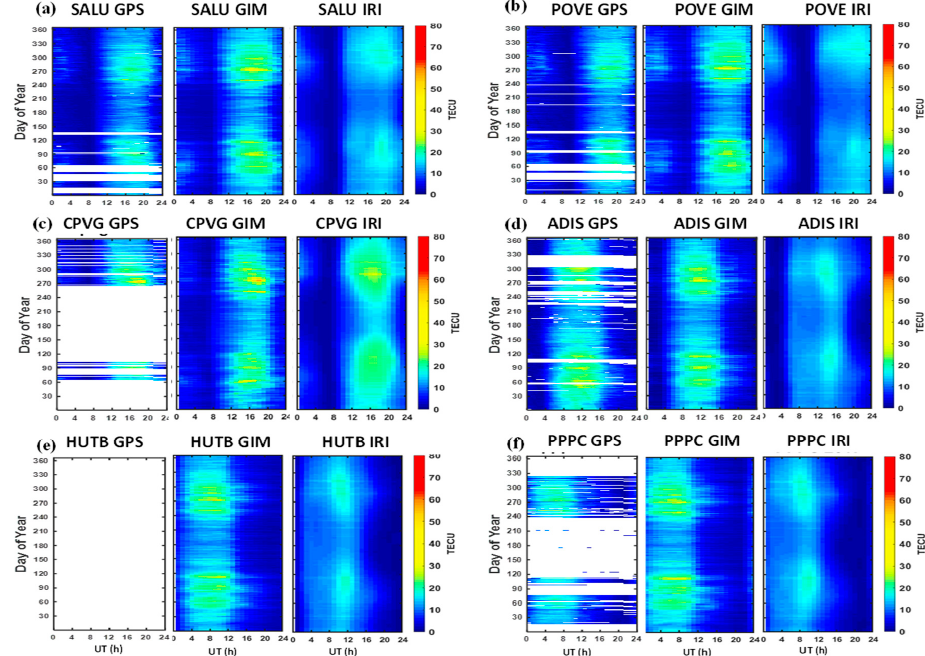
Figure 3. Diurnal variations in GPS-TEC and assessment of GIM and IRI-2016 models at the American (GPS stations: ( a ) SALU and ( b ) POVE), African (GPS stations: ( c ) CPVG and ( d ) ADIS), and Asian (GPS stations: ( e ) HUTB and ( f ) PPPC) longitudes for the year 2017. The details of the GPS stations are mentioned in Table 1.